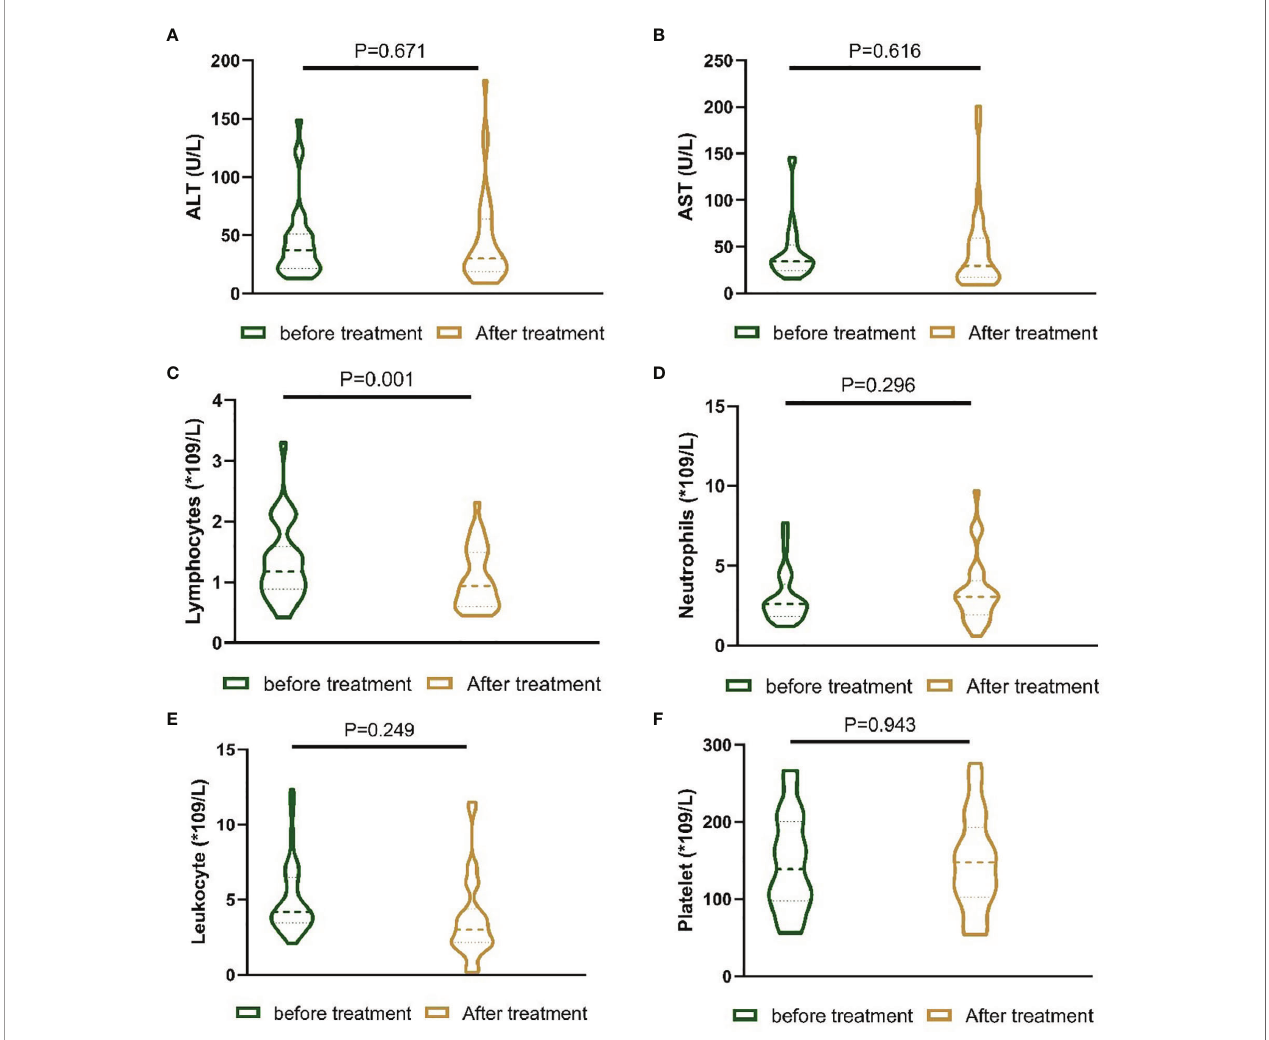
FIGURE 4 | Nested fi gures for changing of liver function and blood index of patients before the treatment and one month after the treatment. (A) Change of ALT; (B) change of AST; (C) change of lymphocytes; (D) change of neutrophils; (E) change of leukocyte; (F) change of platelet.